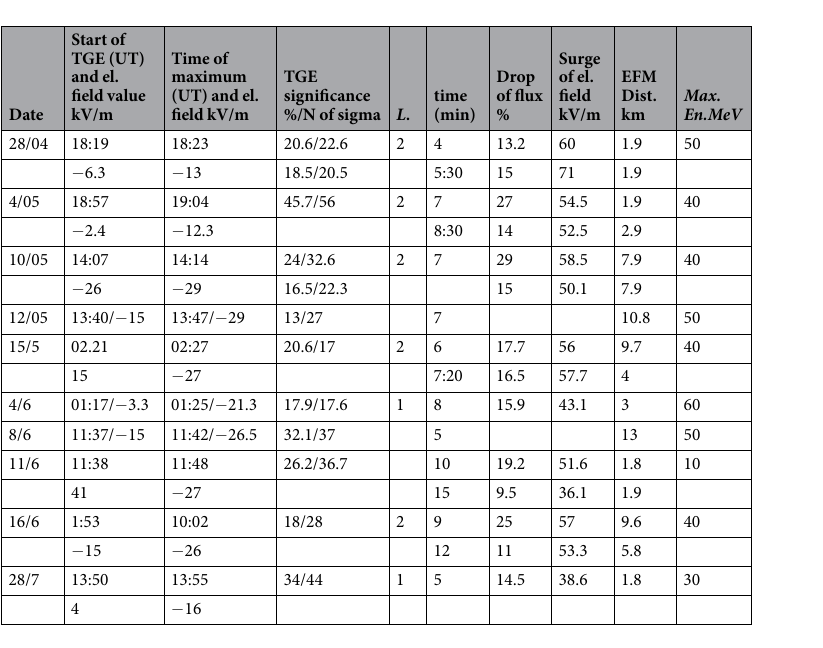
Table 2. Characteristics of the TGE events detected in Spring-Summer